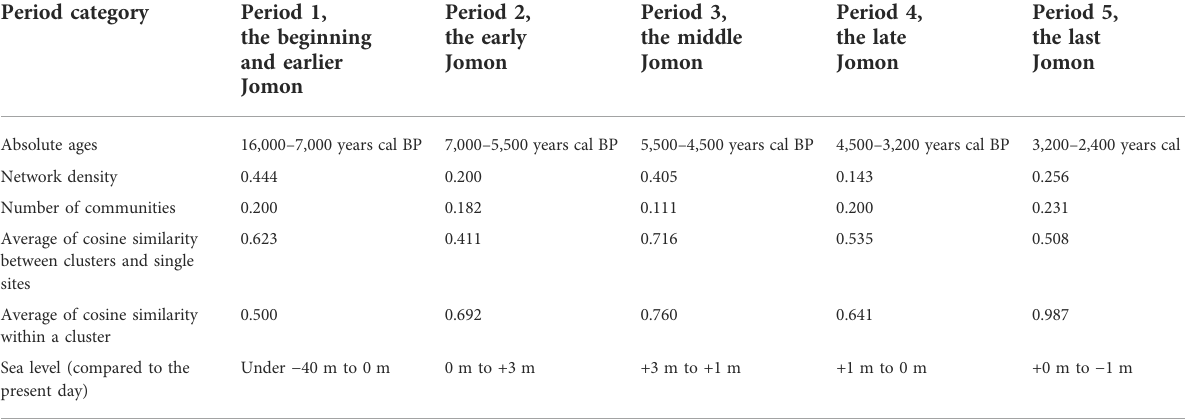
TABLE 2 Indicators of network analysis and sea level in each period